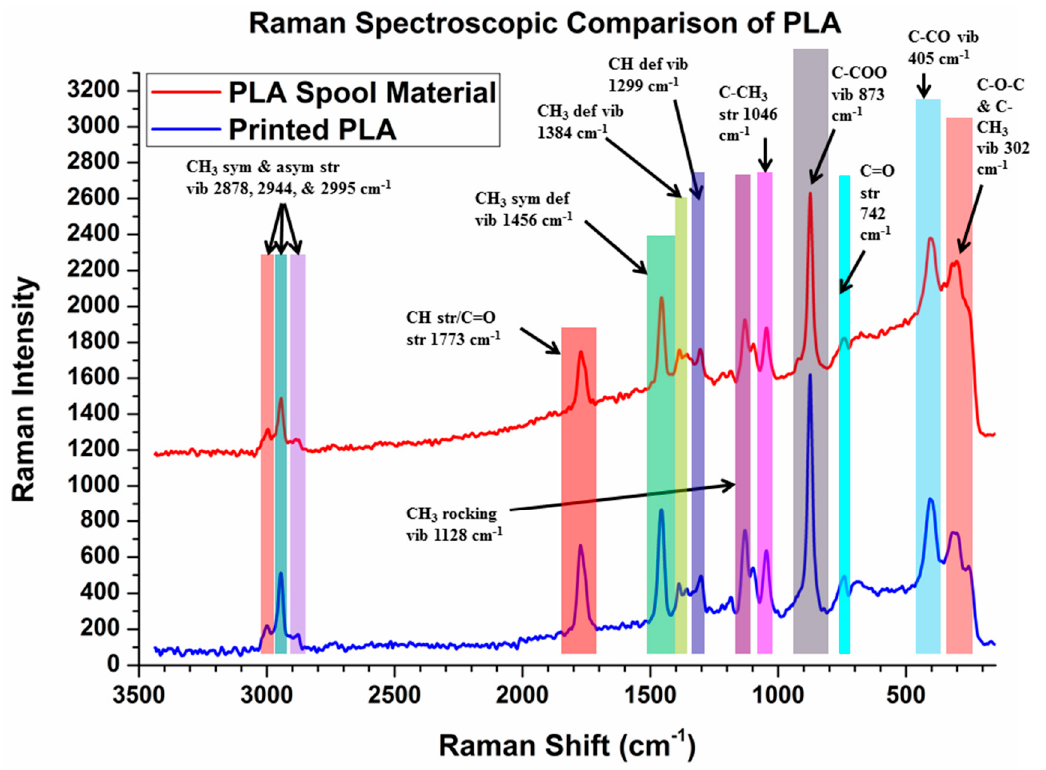
Figure 5. Raman spectroscopic comparison of PLA spool material, printed PLA.